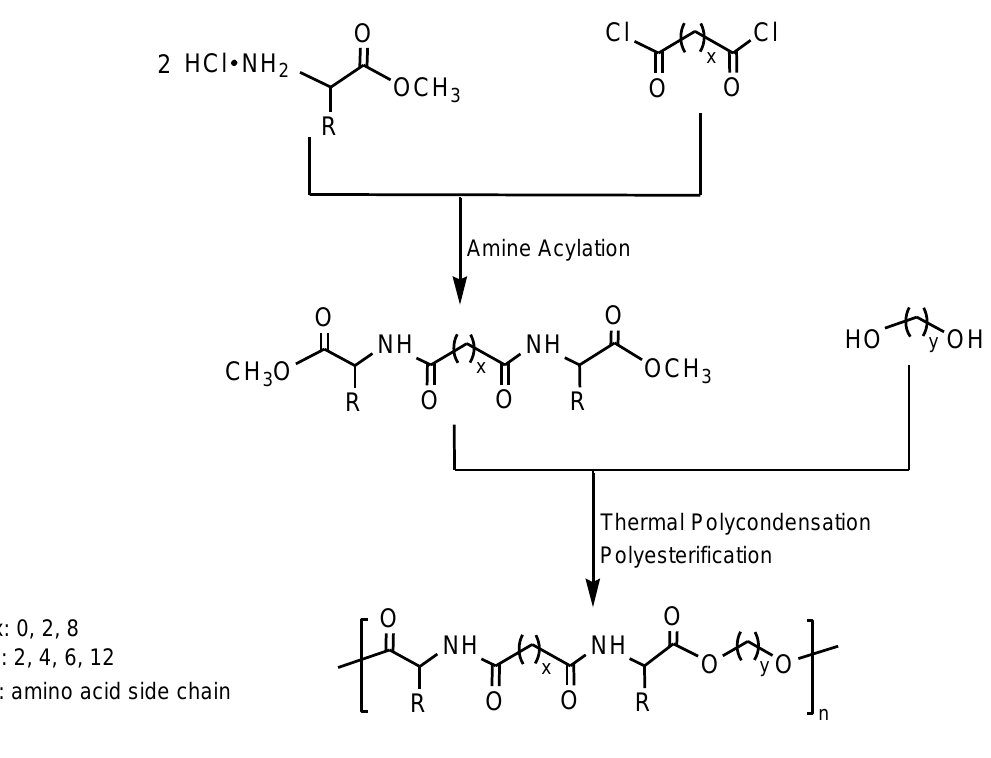
Figure 3. Poly(ester amide)s incorporating  -amino acids by melt polycondensation of a diamide-diester